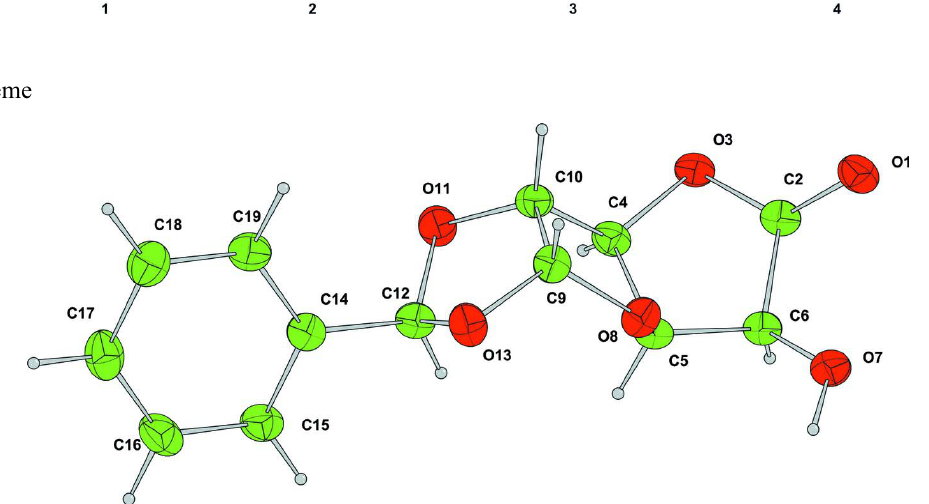
The title compound with displacement ellipsoids drawn at the 50% probability level. H atoms are shown as spheres of arbitary